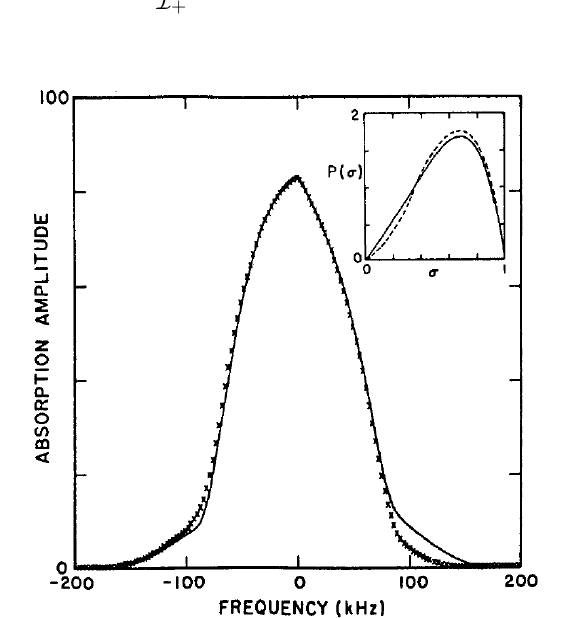
Figure 8. Observed NMR line shape for quadrupolar glass state of solid H 2 for ortho-H 2 concentration x = 0.23 at a temperature of 45 mK in a magnetic field of 5 T, showing asymmetry due to a finite nuclear spin polarization. Reproduced with permission from [27]. Copyright Springer Nature,